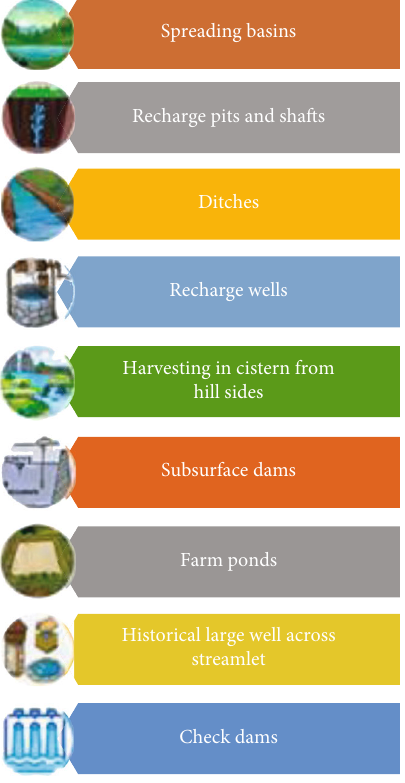
Figure 1: Methods to recharge ground